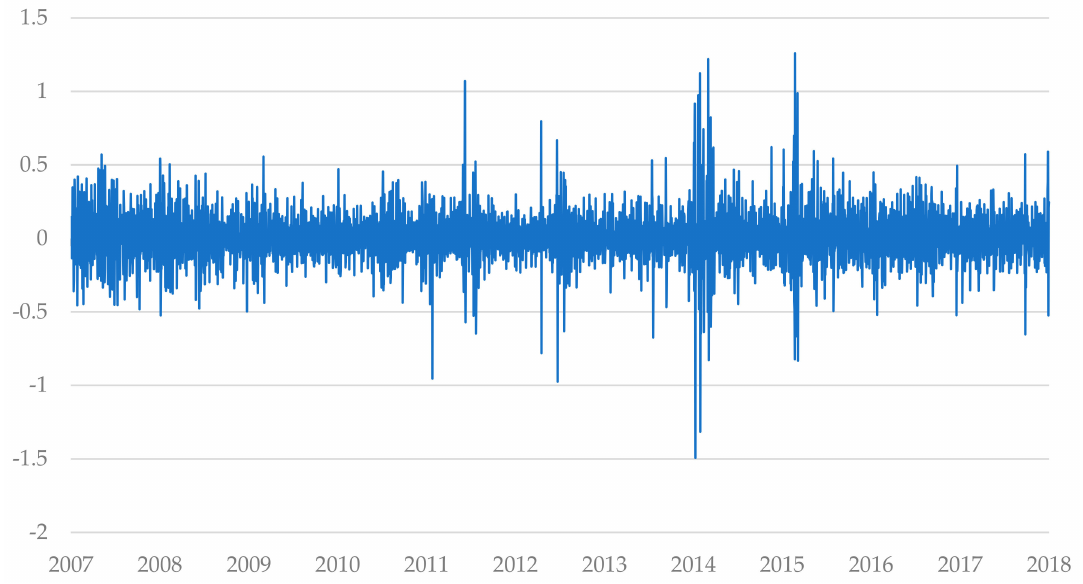
Figure 1. Pennsylvania, Jersey, Maryland Power Pool (PJM) electricity prices log